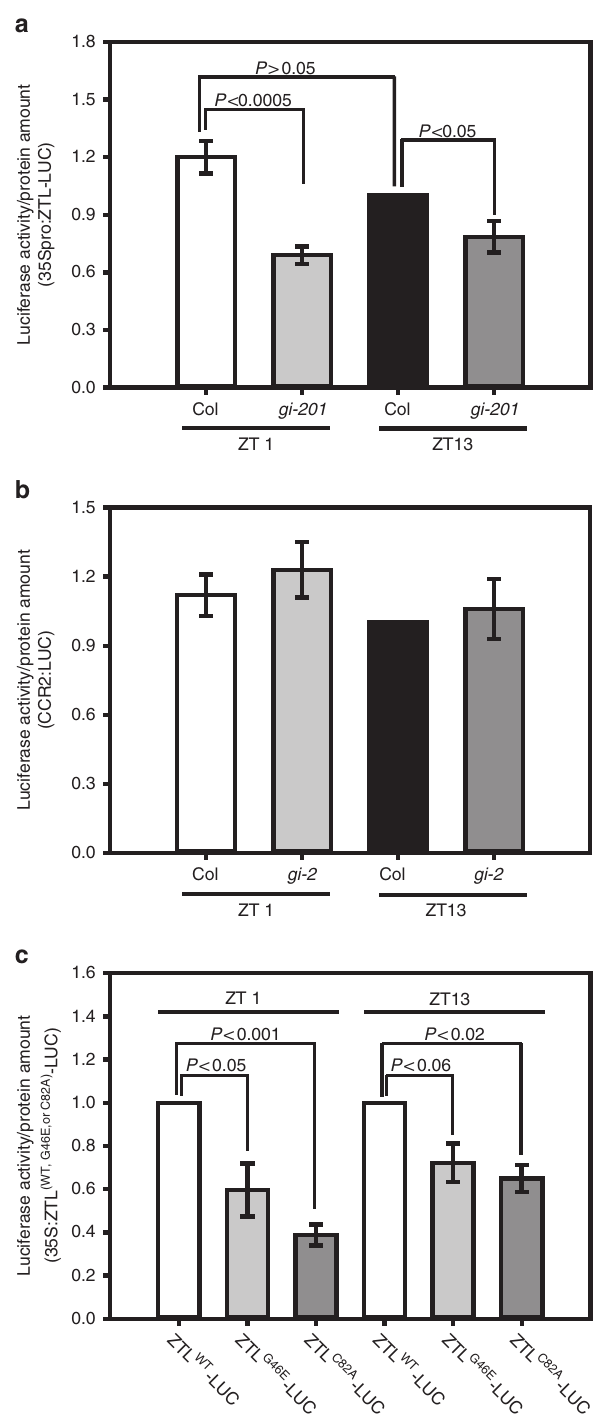
Fig. 3 GI is required in vivo for complete ZTL activity. a Relative-speci fi c activity of ZTL-LUC at ZT1 and ZT13 in the Col and gi-201 background. b Relative-speci fi c activity of LUC from the CCR2:LUC transgene in the Col and gi-2 backgrounds. c Relative-speci fi c activity of ZTL WT -, ZTL G46E -, and ZTL C82A -LUC at ZT1 and ZT13 in the Col background. a – c Speci fi c activity was determined by the ratio of luminescence (enzyme activity) to LUC protein levels derived from ZTL WT -, ZTL G46E -, ZTL C82A -LUC or LUC protein alone. See “ Methods ” for details. Data are means ± s.e. of eight ( a ) or four ( b , c ) independent